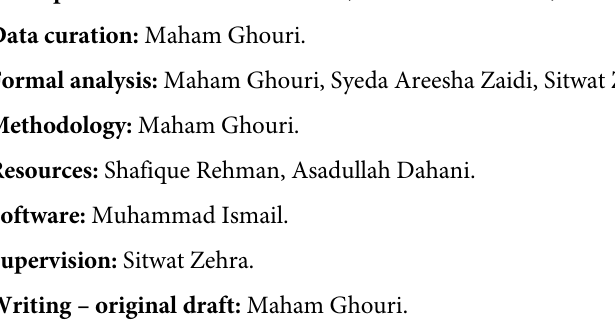
S1 Table. ACR/EULAR criteria 2010 for the selection of